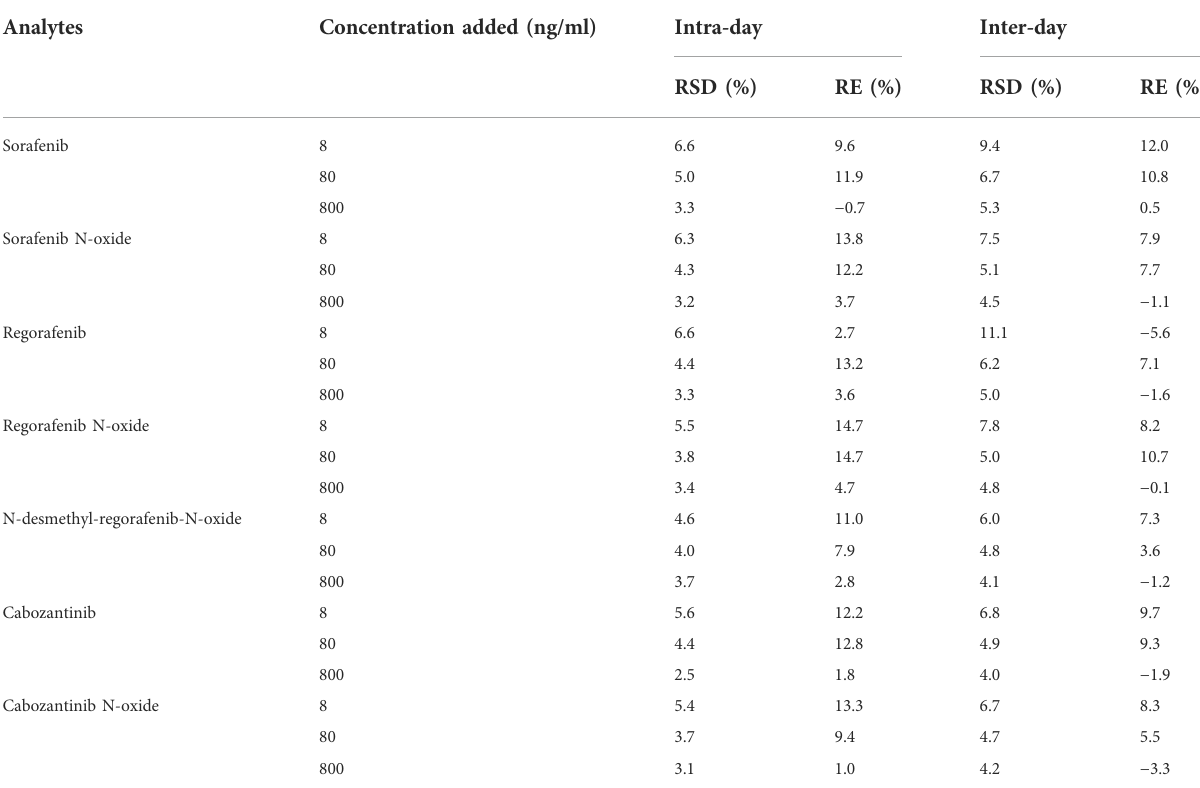
TABLE 3 The determination of accuracy and precision of the analytes in rat plasma.